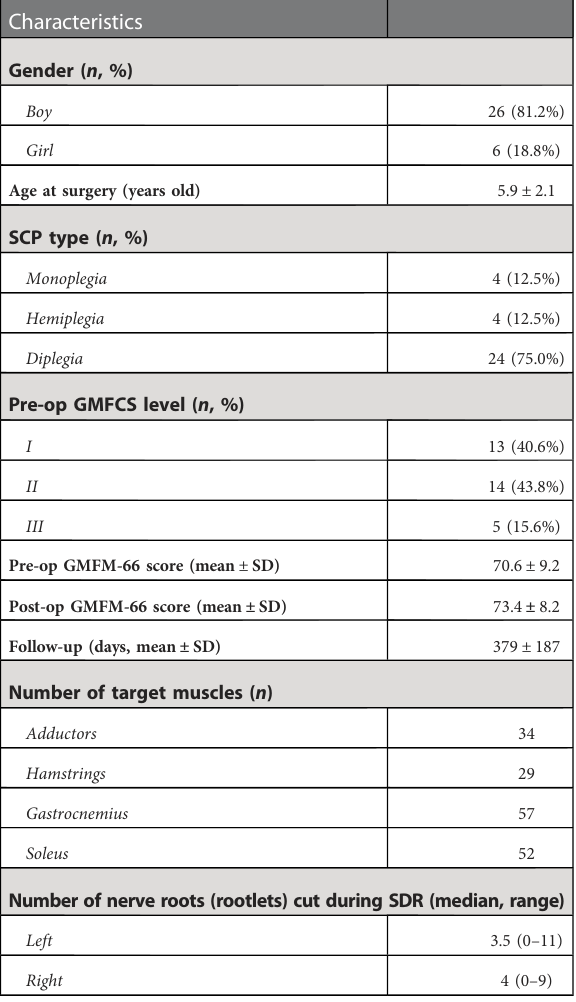
TABLE 1 Demographic and clinical data of cases included in this study.